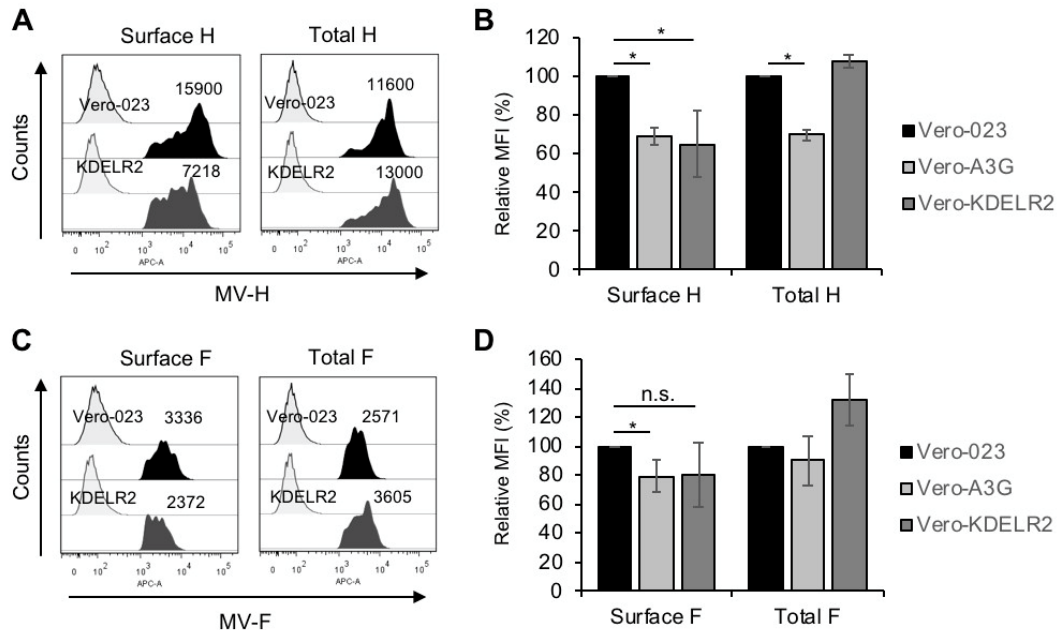
Figure 3. KDELR2 over-expression leads to a reduction of MV-H and -F surface expression. Vero-023, Vero-A3G, and KDELR2 over-expressing Vero cells (KDELR2) were infected with MV-eGFP at a MOI of 0.1 for 48 h. Cells were fixed and stained (surface expression), or fixed, permeabilized, and stained (total expression) with monoclonal antibodies to MV-H ( A , B ) and MV-F ( C , D ) and secondary antibodies. The MV-H and –F expression was analyzed by flow cytometry. Examples of representative experiments with isotype controls (left signals) and surface and total H ( A ) and F ( C ) expression (dark signals) are shown. The results of three experiments are summarized in bar graphs ( B , D ). Data of mean fluorescence intensities (MFI) were presented as a percent of control normalized to values of Vero-023 cells. Significances were determined using the Student’s t-test (* p < 0.05; n.s. = not significant).